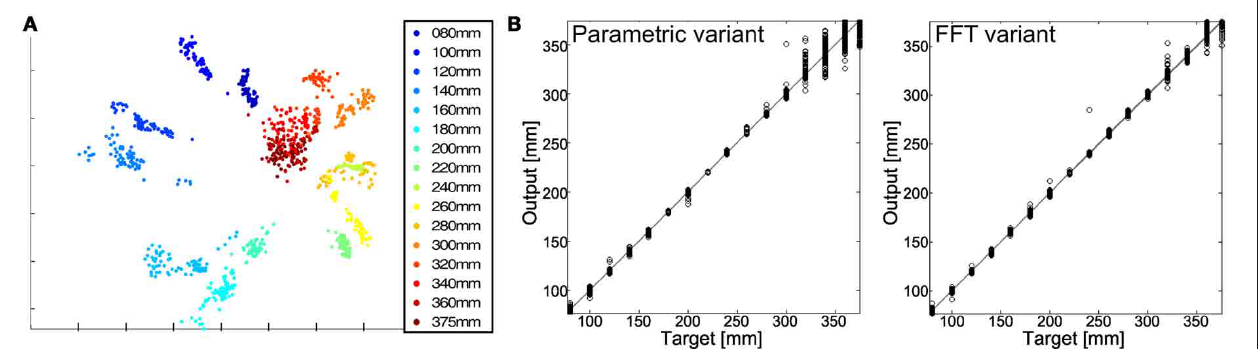
FIGURE 4 | (A) Multi-dimensional scaling and tactile localization. The plot illustrates the separability of different distances. The Fourier spectra of eight materials with a contact distance from 80mm to 375mm were processed using multi-dimensional scaling. This led to a two-dimensional embedding with the pair-wise distances being conserved. Contact locations closer to the base can be distinguished easily (blue clusters do not overlap), while contact locations above about 320mm are challenging to tell apart